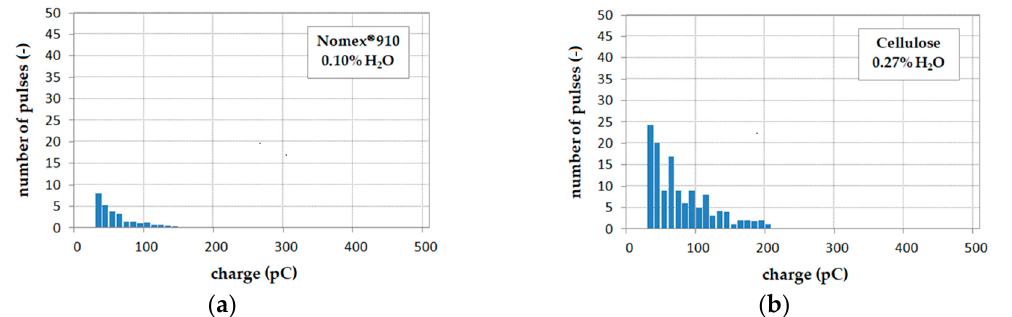
Figure 6. Frequency-amplitude distribution of partial discharges in aramid-enhanced cellulose paper ( a ) and cellulose paper ( b ), conditioned in the same conditions (the lowest moisture in paper); U = 10.9 kV.